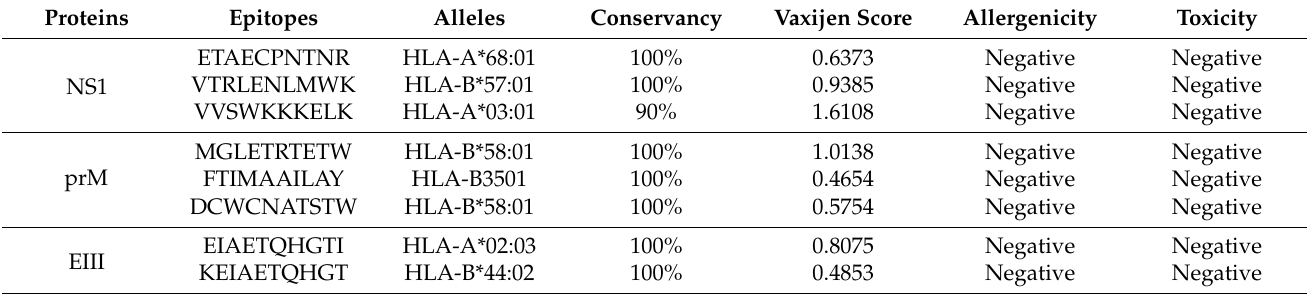
Table 3. List of selected CD8+ CTL epitopes.